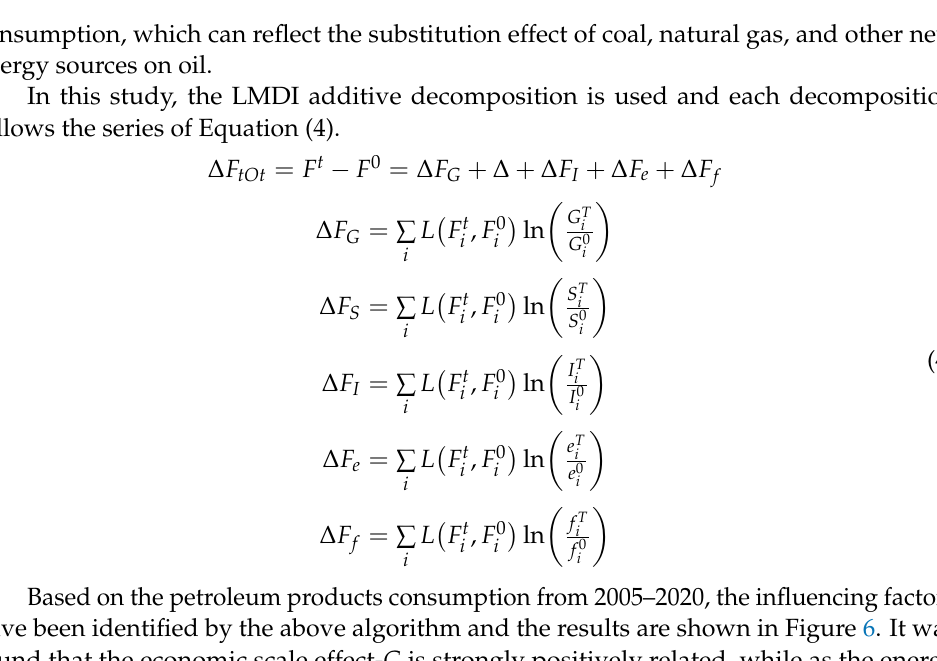
Figure 7. The structure of scenarios and sub-scenarios. Policy Scenarios Baseline Scenario Carbon Peaking Scenario